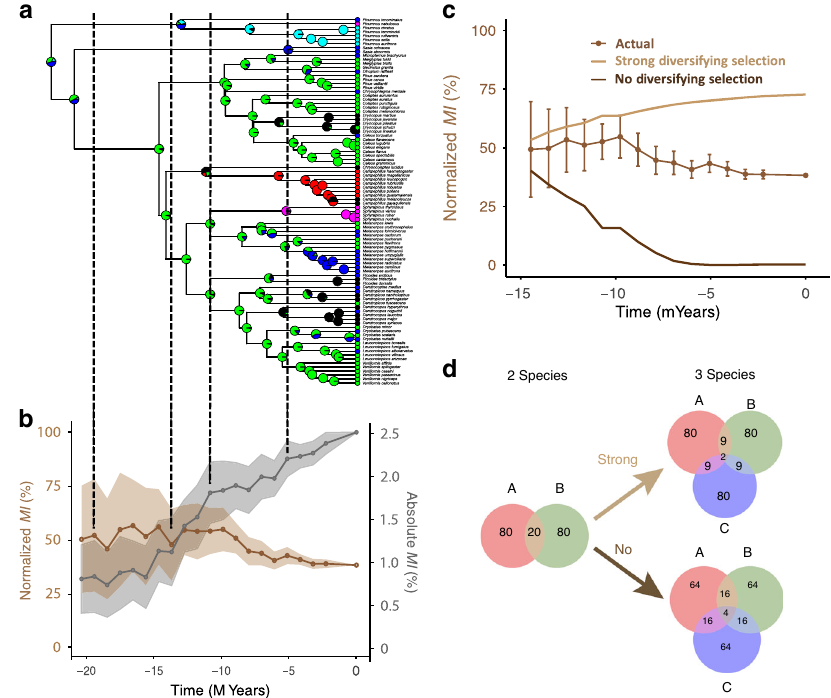
Fig. 3 Evolution of drumming: acoustic structure and information. a Ancestral state reconstruction of drumming types along the woodpeckers ’ phylogenetic tree. Pie charts at nodes represent the probability distribution of existing (colour-coded as in Fig. 2a) drumming types. b simulated information content associated with reconstructed drumming types; normalized overall mutual information ( MI ; brown curve) is scaled on the left y axis, while absolute MI (grey curve) is scaled on the right y axis — see ‘ Methods ’ for details. Shaded error bars show ±1 SD of mean information values obtained in simulations. c Ancestral normalized MI (as in b ) compared to two modelled calculations corresponding to strong (light brown) and no (dark brown) selection pressure for species identity — models included n = 30 simulations and error bars show ±1 SD of mean information values obtained in simulations. See ‘ Analytical simulations of selection for information ’ and Supplementary Fig. 6 for details). d Venn diagrams illustrating the assumptions used to simulate evolutionary scenarios with strong or no diversifying selection in ( c ). Numbers indicate theoretical percent probability of correct classi fi cation (e.g. with a strong diversifying selection, the correct classi fi cation probability remains at 80% for all species when a new species emerges, but drops to 64% when no diversifying selection is applied). Source data are provided as a Source data fi